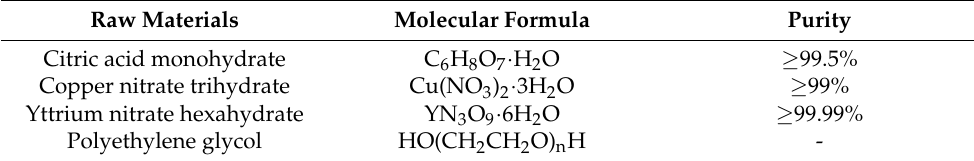
Table 1. Raw materials for the synthesis of Cu-1wt.%Y 2 O 3 powders. Raw Materials Molecular Formula